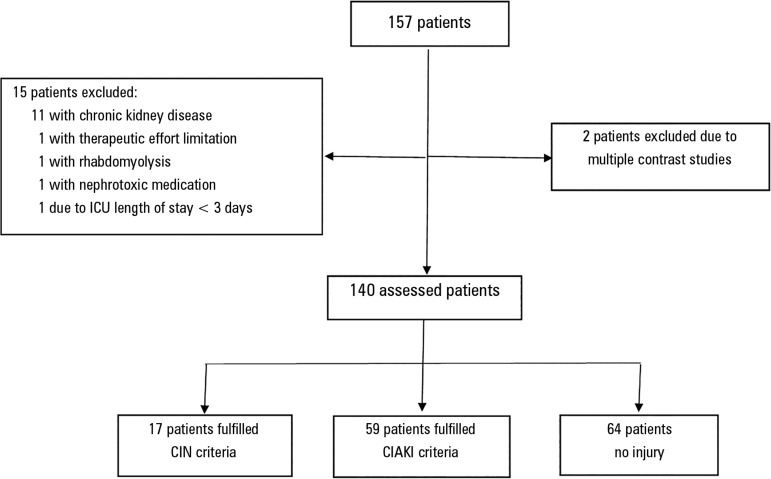
Study design. Initial population sample, excluded patients and the
division into two groups.ICU - intensive care unit; CIN - contrast-induced nephropathy; CIAKI -
contrast-induced acute kidney injury.